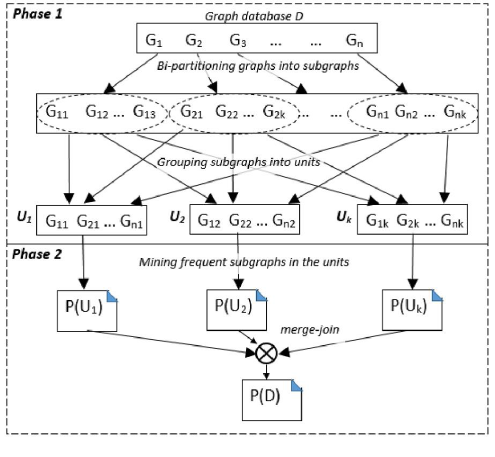
Fig. 17 PartMiner partition method [46] .